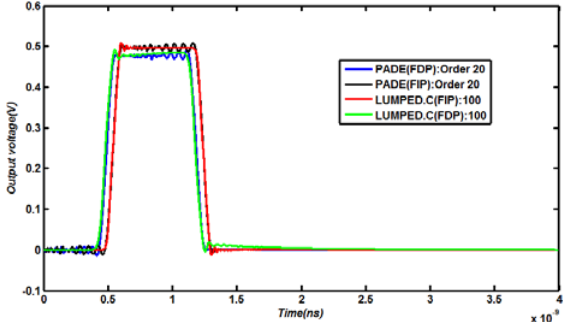
Fig. 9. Transient response of the circuit shown in Fig. 2